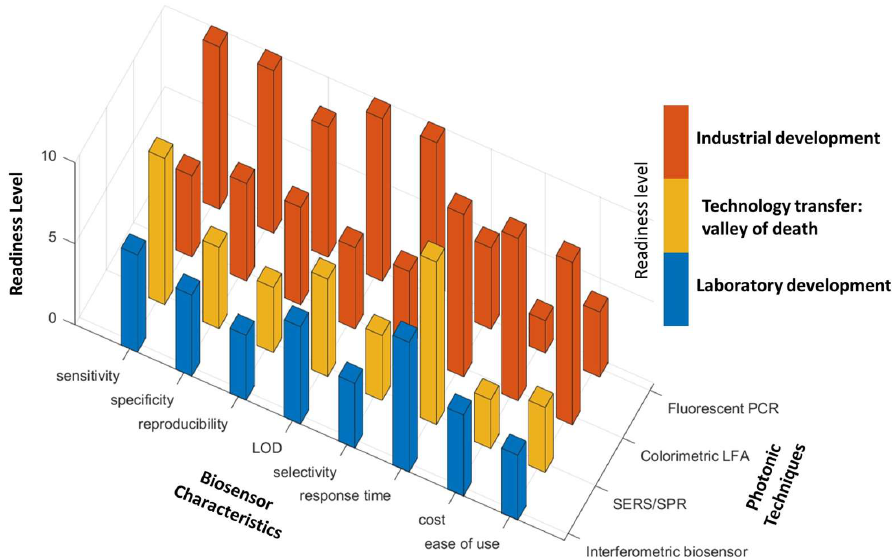
Figure 4. Prospects of different optical techniques for COVID-19 testing. The x coordinate indicates difference biosensor characteristics, the y axis indicates techniques, and the z coordinate represents the relative performance of each technique for its characteristic feature. The color of the column refers to the technical readiness level of each technique indicated in arbitrary values. The higher the value of z coordinate is, the more mature and advantageous the characteristic of a specific technique is, compared to other techniques. It is worth noting that this figure shows a relative comparison of different techniques’ characteristics and features in general. When it comes to a specific product or device, the characteristics may vary depending on how it is designed and developed. It is possible that a specific product based on a high-readiness-level technique is not ready on market yet due to other